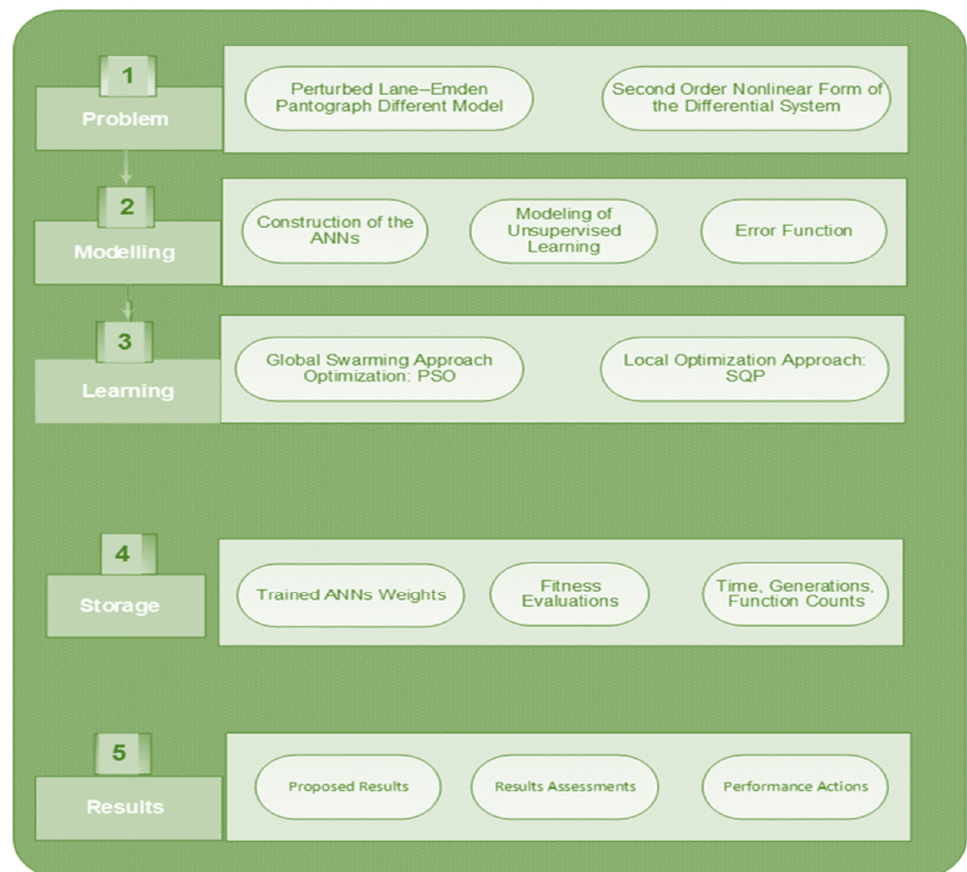
Figure 2. Proposed ANNs-PSOSQP structure for the mathematical form of the NSPM-SK.